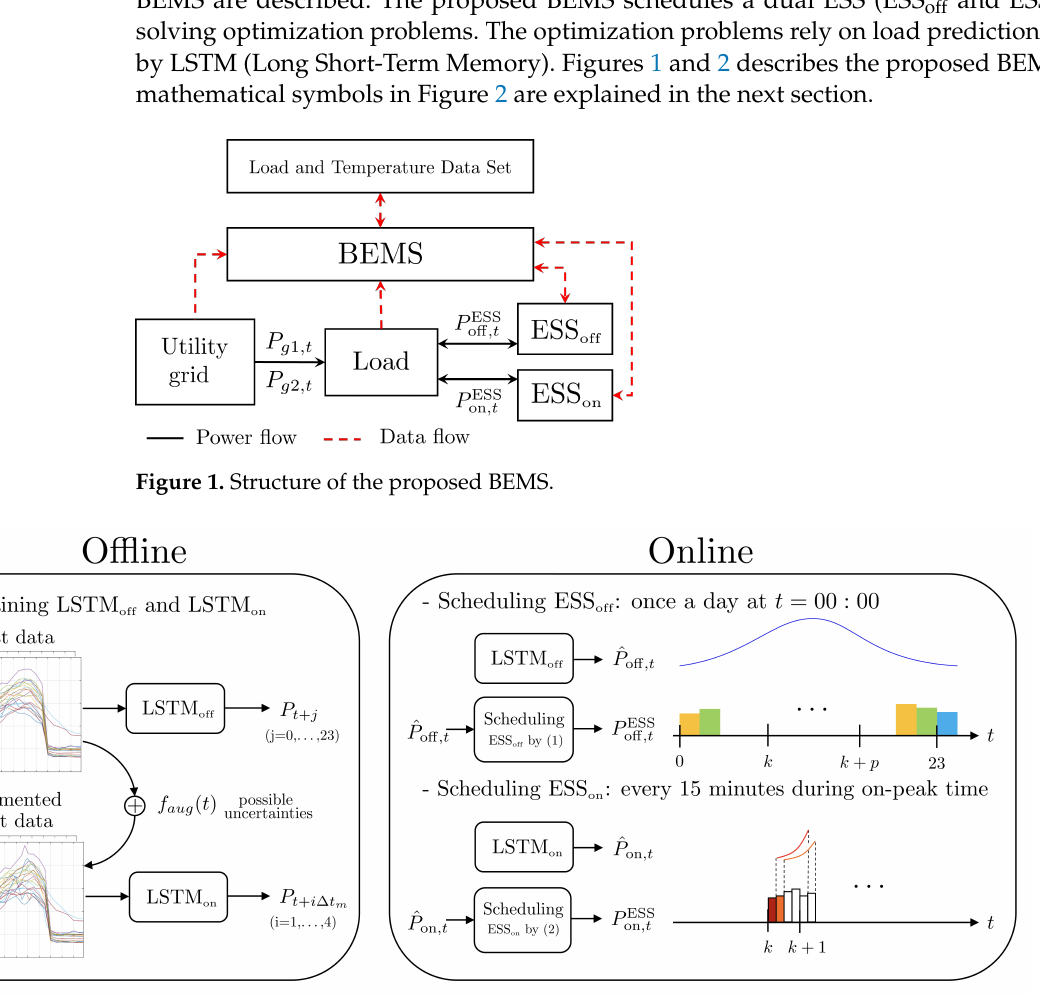
Figure 2. The structure of the proposed BEMS